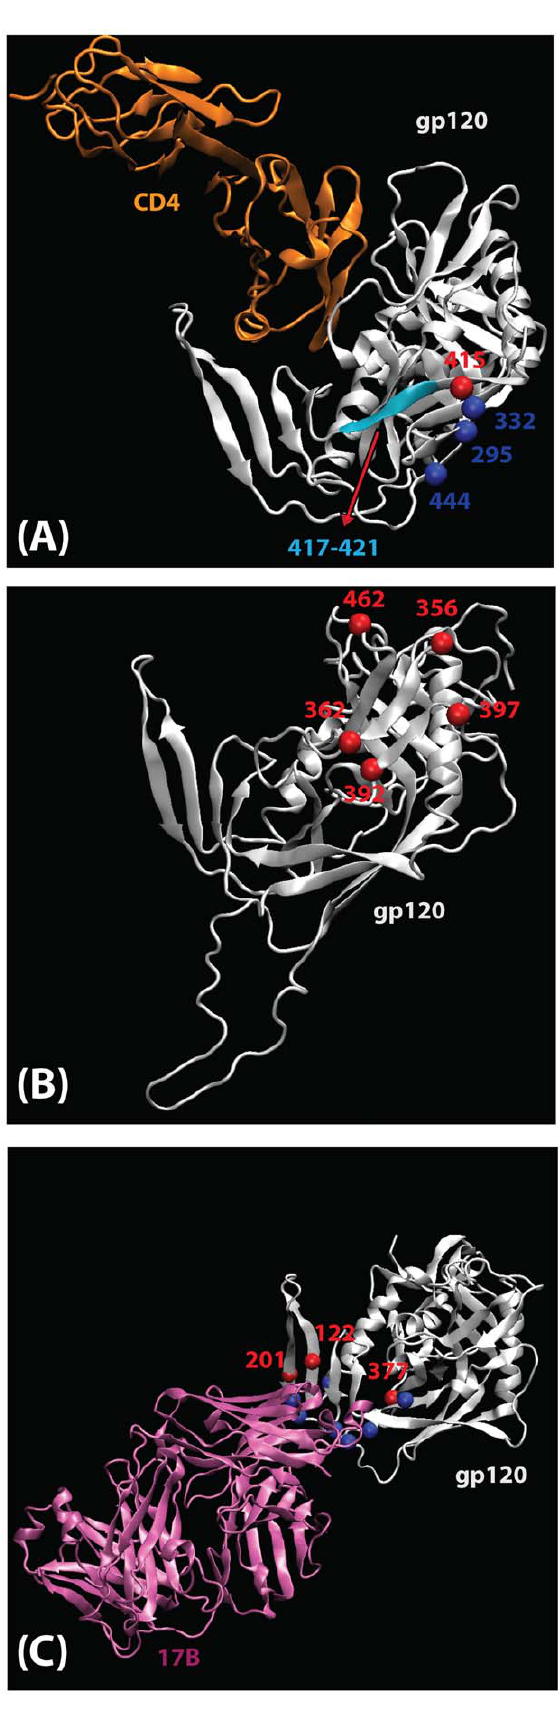
Figure 1. Mapping of signature sites (red) on the three- dimensional structure of gp120 (silver). A ribbon structure of the HIV-1 gp120 core + V3 in the CD4-bound conformation is shown in white. ( A ) Key residues involved in co-receptor and antibody (2G12, b12, b13 and F105) binding that are proximal to the position 415 are shown. Residues 295 and 332, that contribute to the 2G12 epitope, and residue 444, that is important for co-receptor binding, are shown as blue balls. A motif spanning the region 417 to 421 (cyan color) that is proximal to position 415 and contains residues that take part in binding to coreceptor (419), b12 (417–419), b13 (419–421) and F105 (421). CD4 (orange) is shown for better visualization of receptor binding site region. ( B ) Locations of signature patterns involving glycan motifs (N- notP-[ST]). ( C ) Spatial locations of signature sites within a set of functional sites (blue) associated with CCR5 binding. The 17b antibody Fab is included to mark the region in gp120 that takes part in CCR5 binding. Signature sites are labeled with HXB2 reference